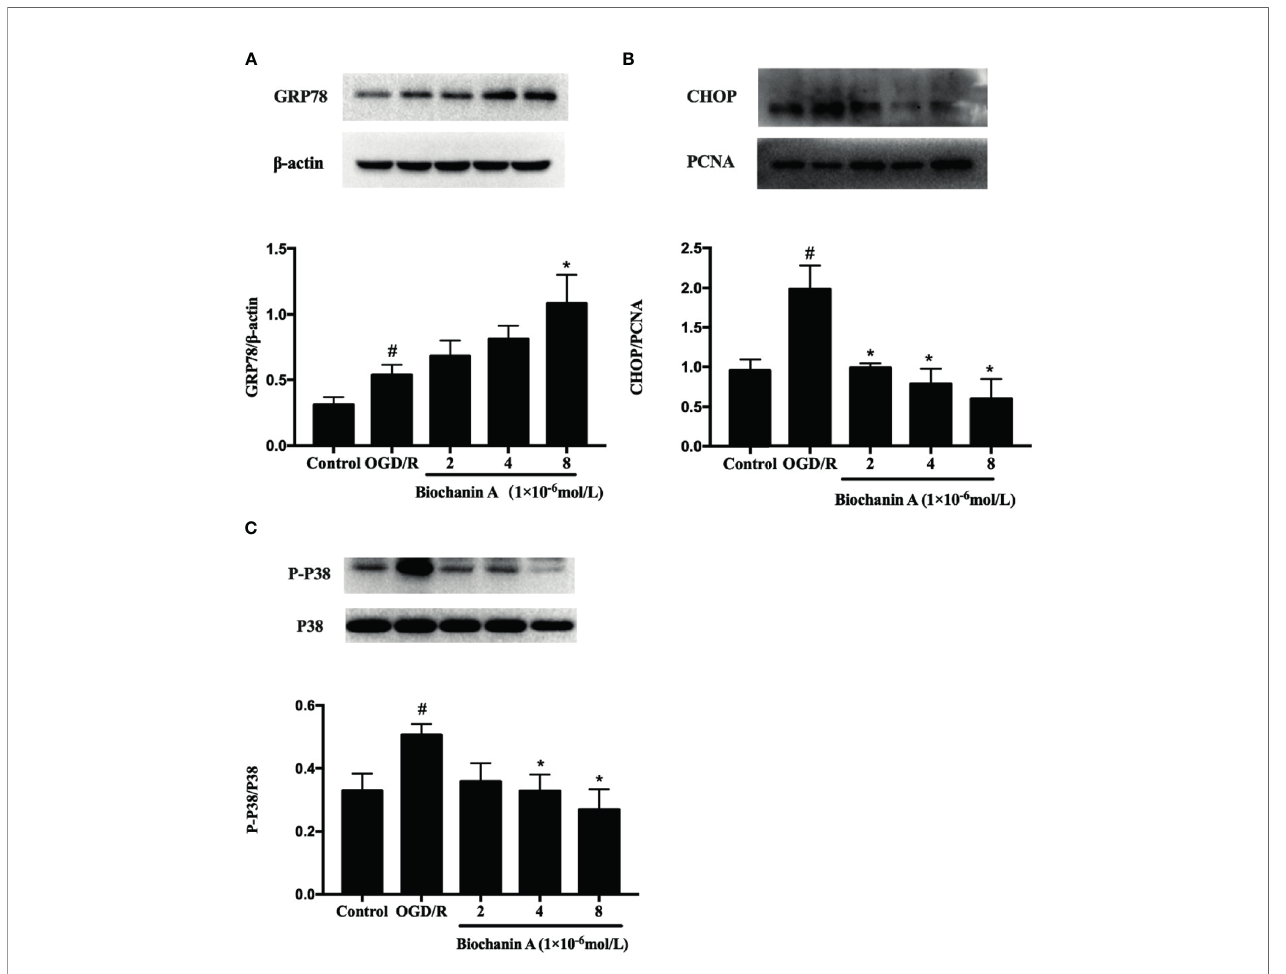
FIGURE 4 | Biochanin A ameliorated endoplasmic reticulum stress and inhibited the phosphorylation activity of p38 in OGD/R neurons. (A) Protein expression of GRP78 in primary cortical neurons with OGD/R induction. b -actin were used as internal controls. (B) Protein expression of CHOP in primary cortical neurons with OGD/R induction. PCNA were used as internal controls. (C) Effects of biochanin A on the phosphorylation activity of p38 in primary cortical neurons after OGD/R. The ratio of p-p38 to total p38 was used to evaluate protein activity. Results were presented as mean ± SE, n = 3. # P < 0.05, the OGD/R group vs. the control group; *P < 0.05, vs. the OGD/R